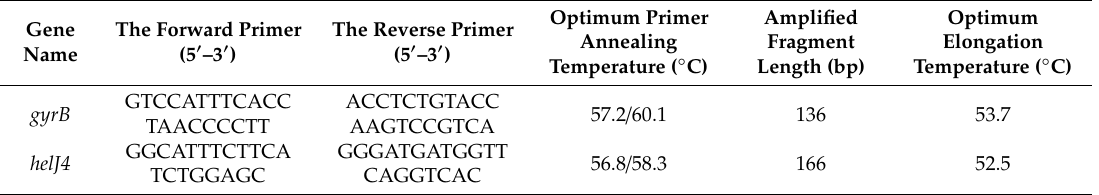
Table 1. Primers used to amplify the gyrB housekeeping gene and helveticin J of L. helveticus D75 and D76.